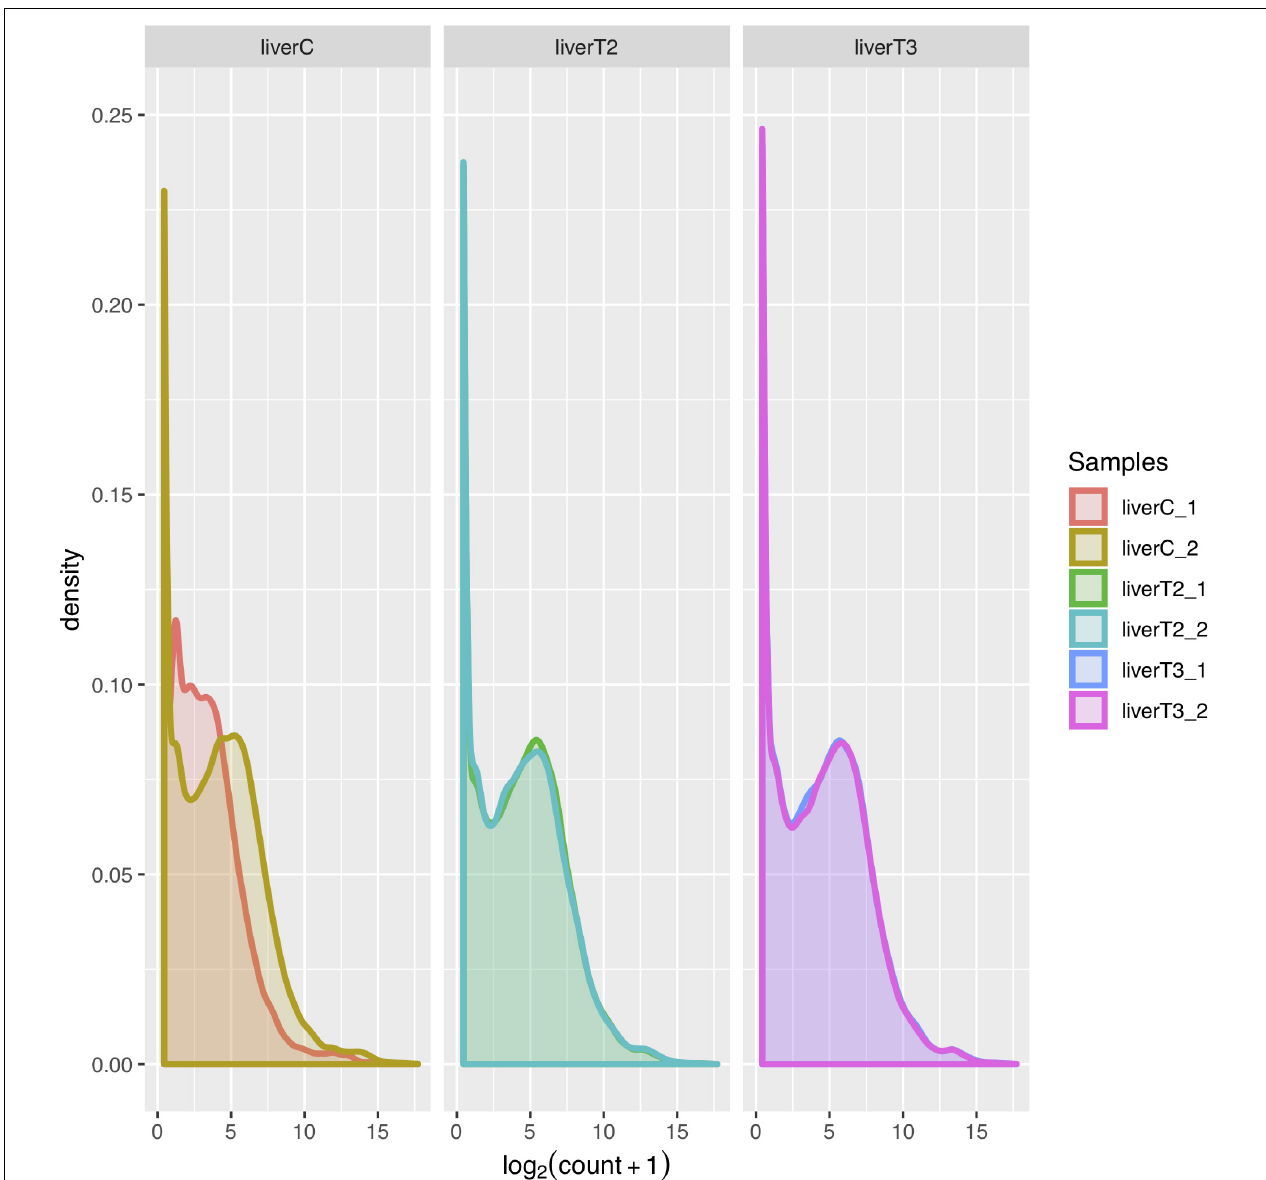
FIGURE 4 | Density plots. The count distribution between replicates and